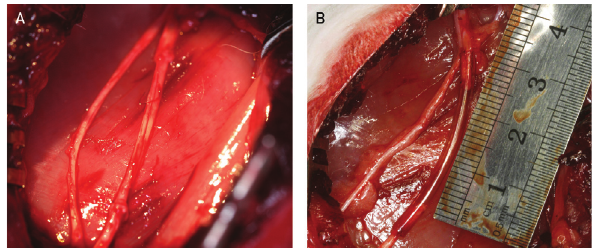
Fig. 2 Reconstruction of the tibial portion of the sciatic nerve. The proximal and distal ends of the nerve were either reconstructed with autologous nerve graft (ANG), ( A ) or fi xed by 10 – 0 epineurial sutures eachwitha2-mm overlapinside 3-cm chitosantube ( B ), creatinga2.6- cm gap between the two ends and microsurgically